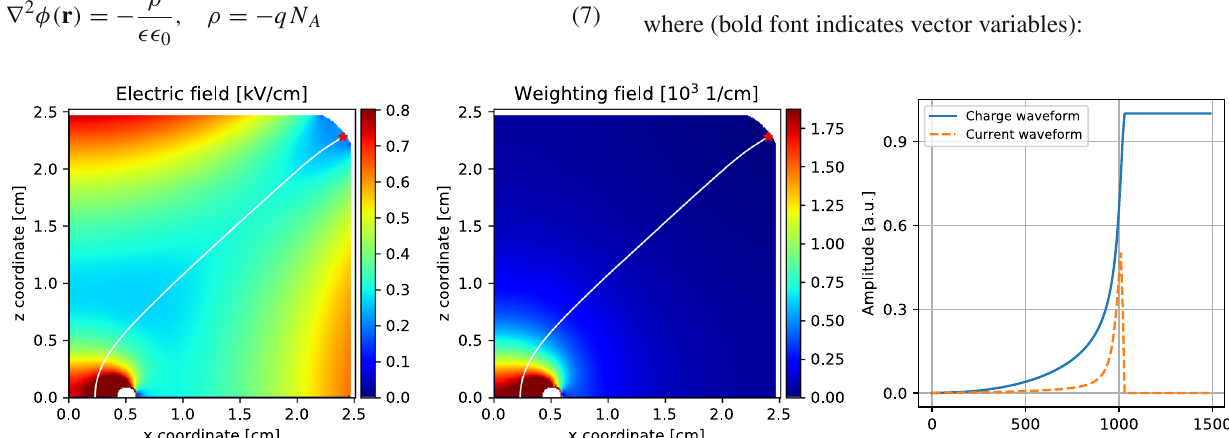
els, originating from the γ -ray interaction point (red star). The current waveform (orange dashed line, right panel) is a derivative of the charge